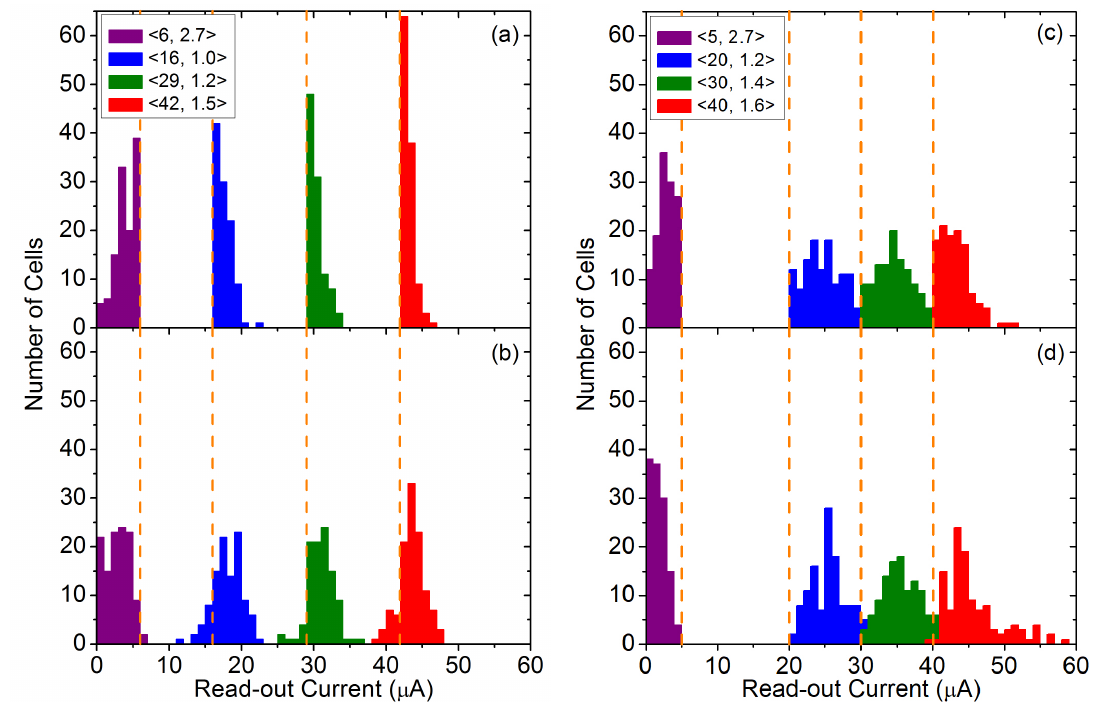
Figure 2. Histograms of the experimental read-out current distributions measured just after the switching transition ( a – c ) and at the end of the M-ISPVA; ( b – d ) for the four optimized conductive levels ( a , b ): HRS ( < 6, 2.7 > ), LRS1 ( < 16, 1.0 > ), LRS2 ( < 29, 1.2 > ), and LRS3 ( < 42, 1.5 > ); and for the four non-optimized conductive levels ( c , d ): HRS ( < 5, 2.7 > ), LRS1